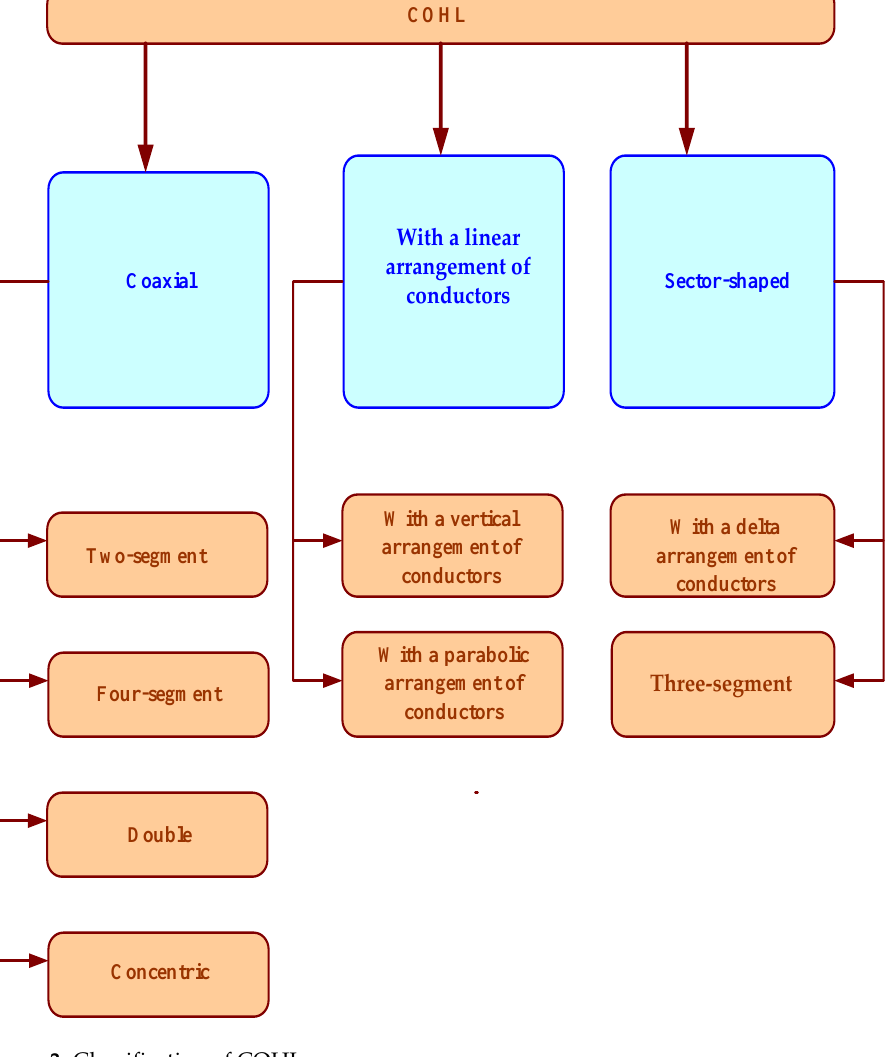
Figure 3. Classification of COHLs.